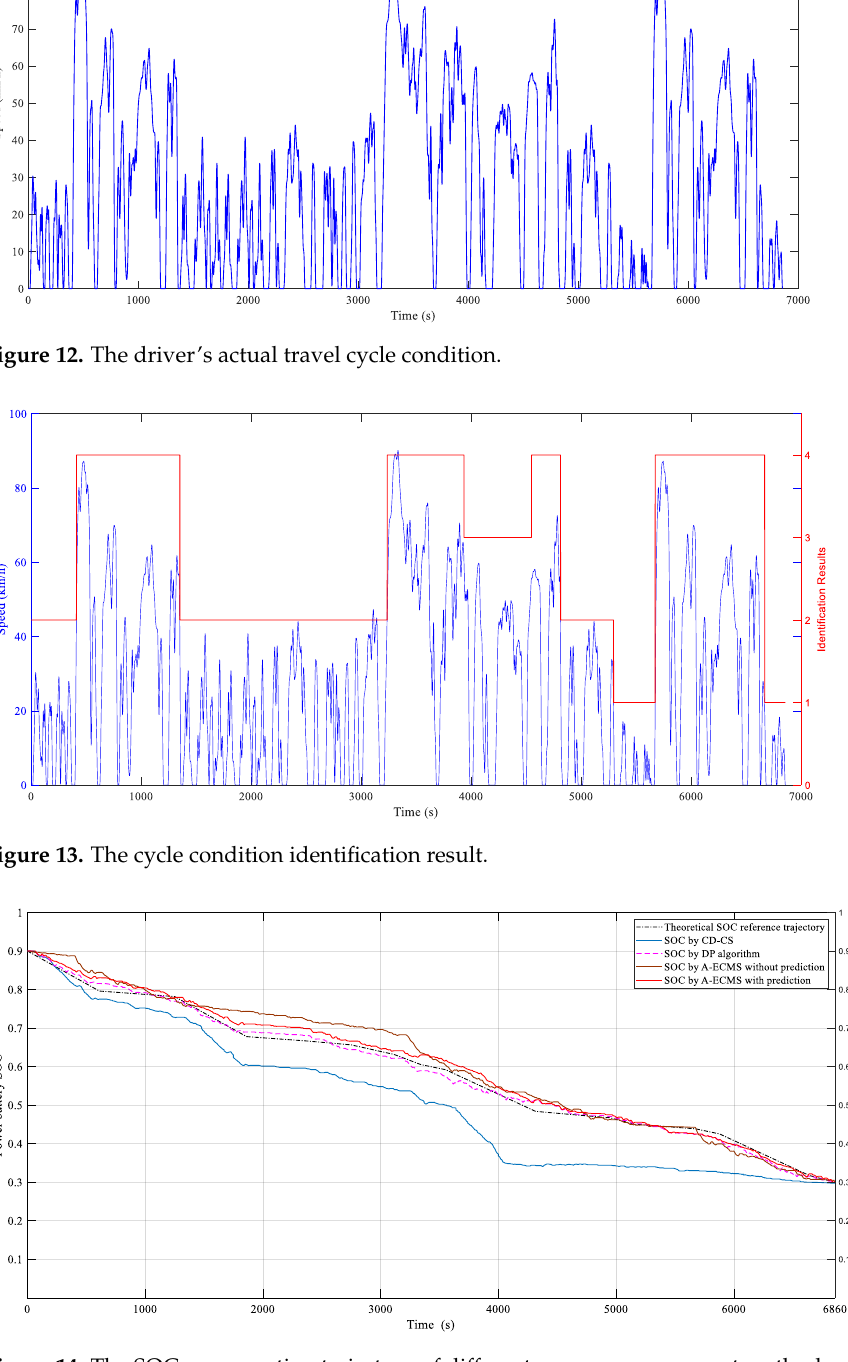
Figure 14. The SOC consumption trajectory of different energy management methods.